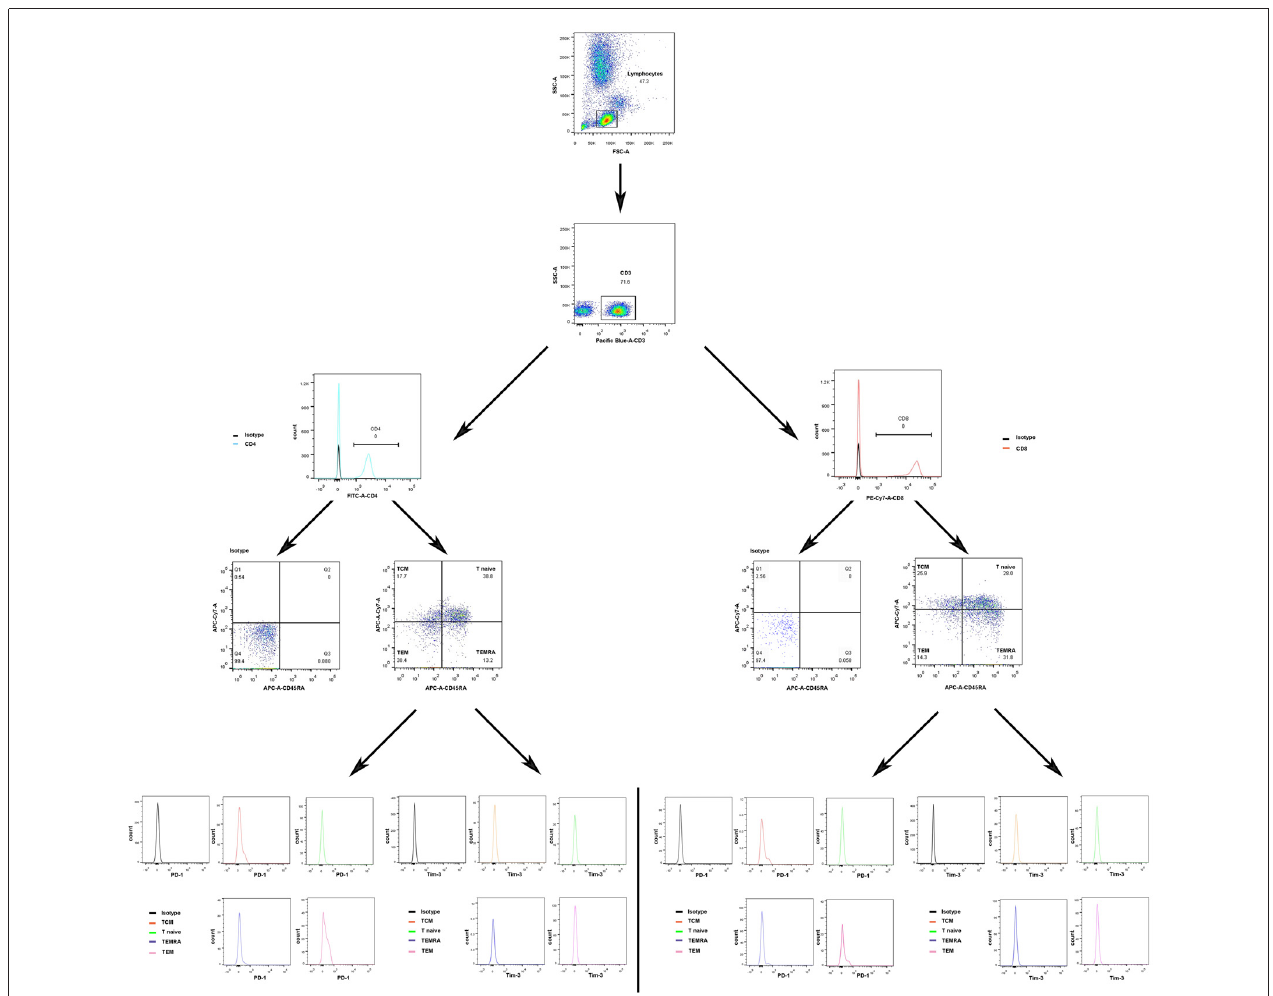
FIGURE 1 | Gating strategies to identify different immune cell